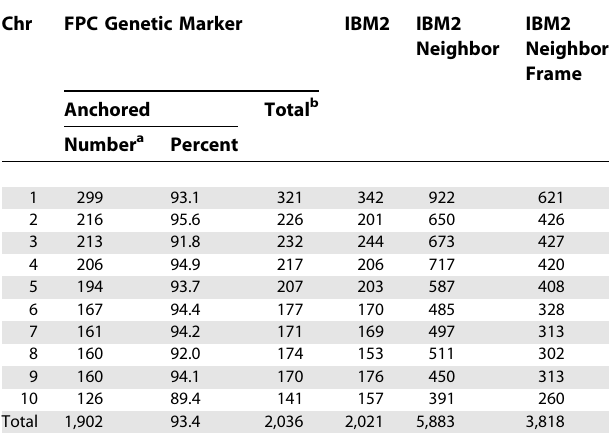
Table 1. Maize Genetic Markers Chr FPC Genetic